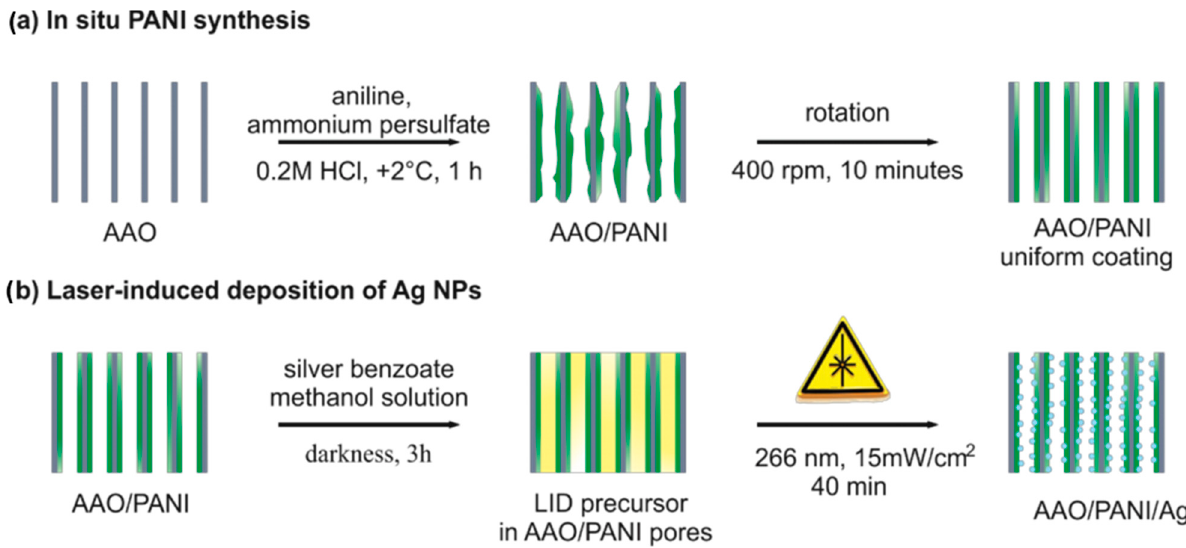
Figure 1. Schematic presentation of AAO/PANI/Ag nanocomposite synthesis procedure; ( a ) PANI synthesis on AAO template; ( b ) laser-induced deposition of Ag NPs on 3D PANI.